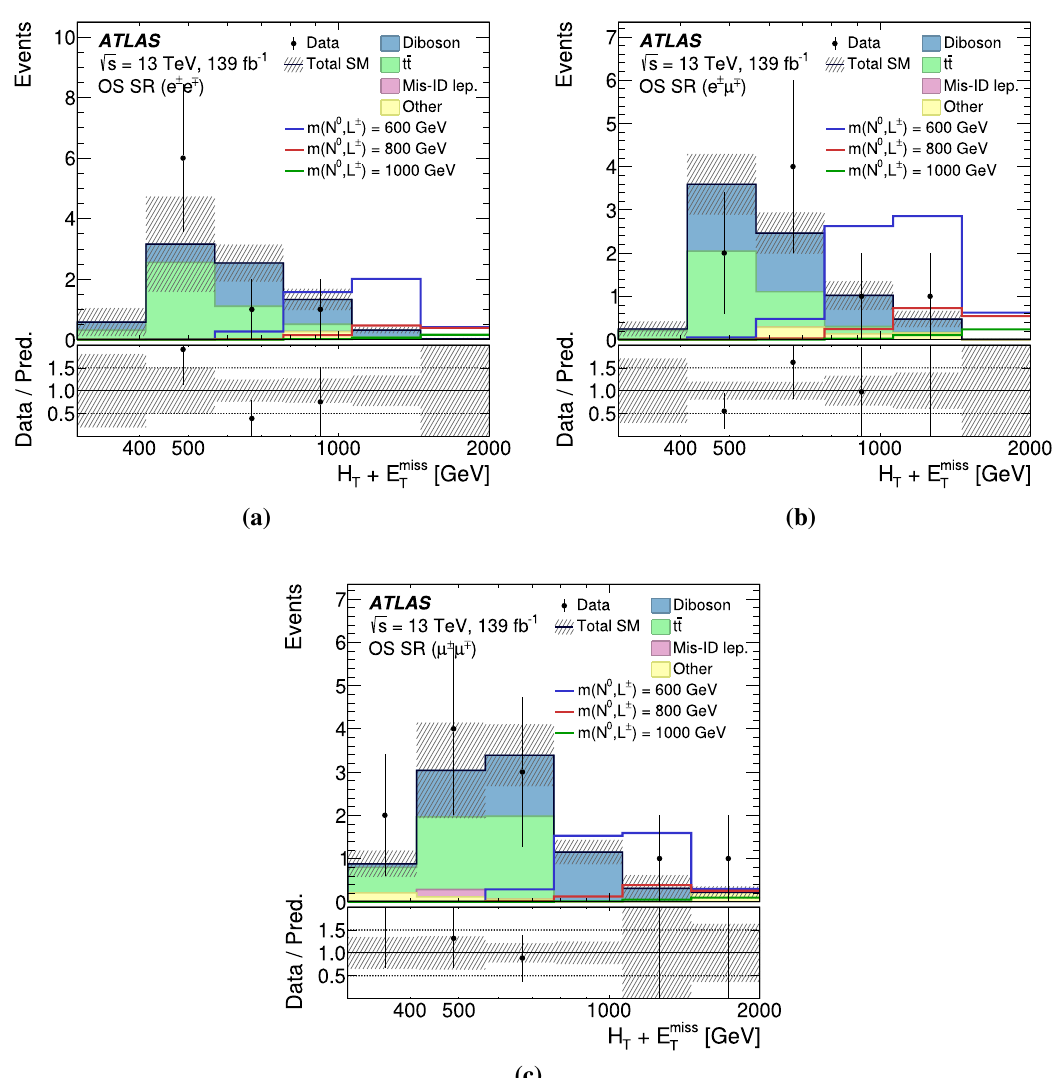
Fig. 3 Distributions of H T + E miss in opposite-sign signal regions, bands include all systematic uncertainties post-fit with the correlations T namely a the electron–electron signal region, b the electron–muon sig- between various sources taken into account. Errors on data are statis- nal region, and c the muon–muon signal region after the background- tical only. The lower panel shows the ratio of the observed data to the only fit described in the text. The coloured lines correspond to signal estimated SM samples with the N 0 and L ± mass stated in the legend. The hatched